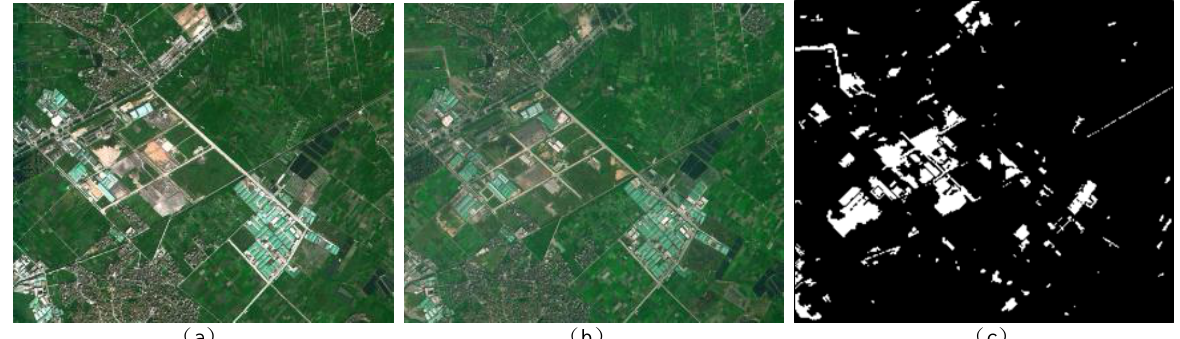
Figure.5 Dataset used in the experiment. (a) Remote sensing image of year 2006 (b) Remote sensing image of year